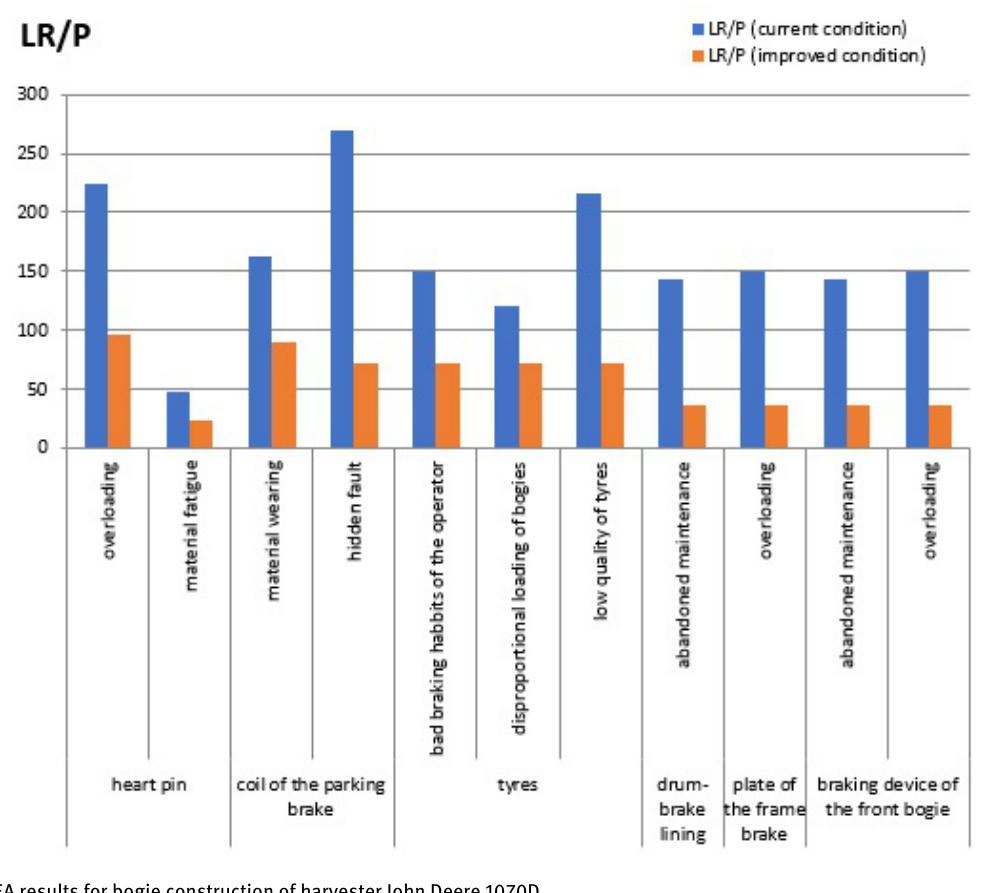
Figure 1: FMEA results for bogie construction of harvester John Deere 1070D